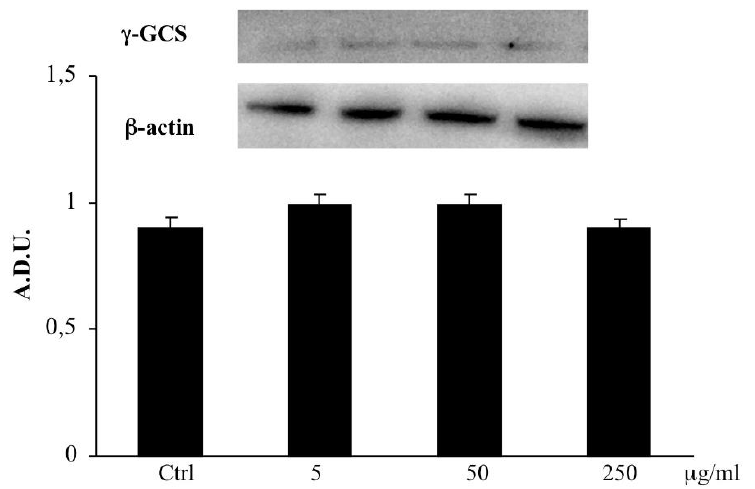
Figure 6. Immunoblotting of (γ-glutamylcysteine synthetase) γ-GCS levels in CaCo2 cells untreated and treated for 72 h with methanolic extract of B. etnensis Raf. at different concentrations (5–250 µg/mL). Values are the mean ± SD of four experiments performed in triplicate. *Significant vs. untreated control cells: p < 0.001.